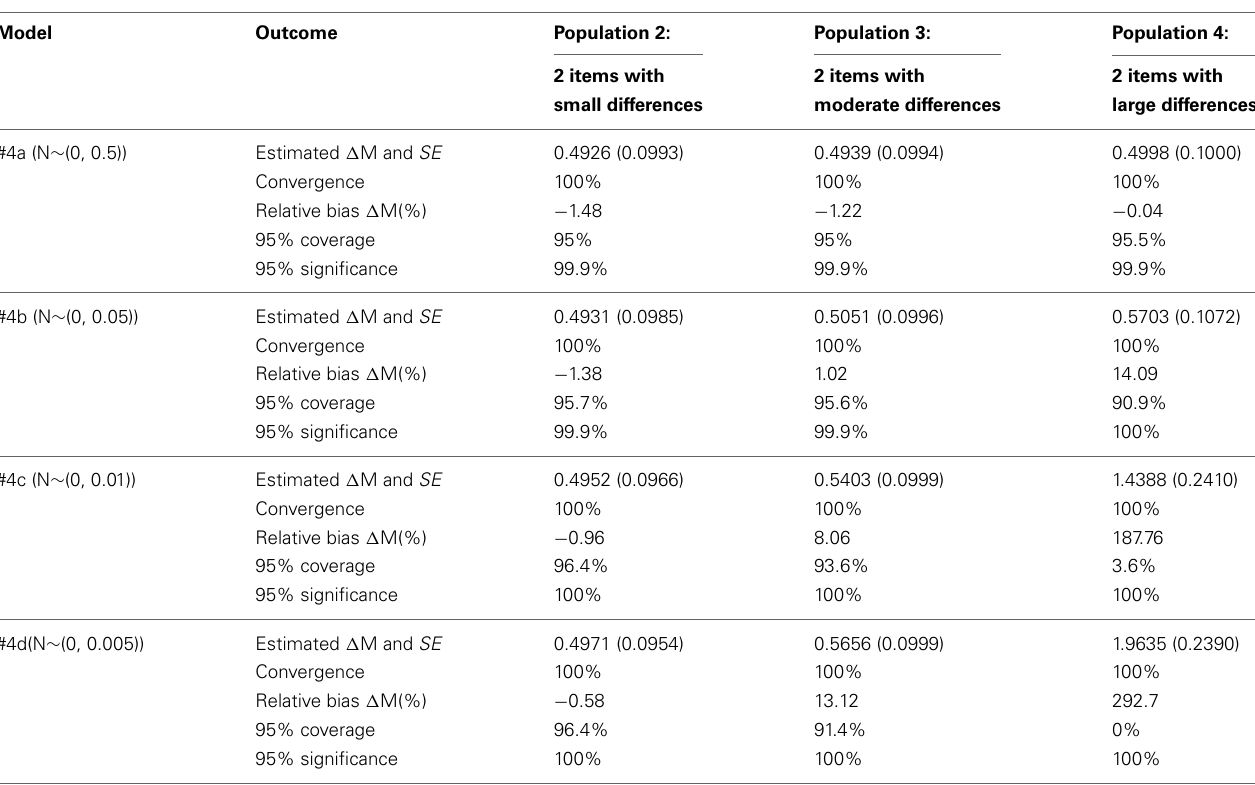
Table 6 | Simulation results for Model 4.